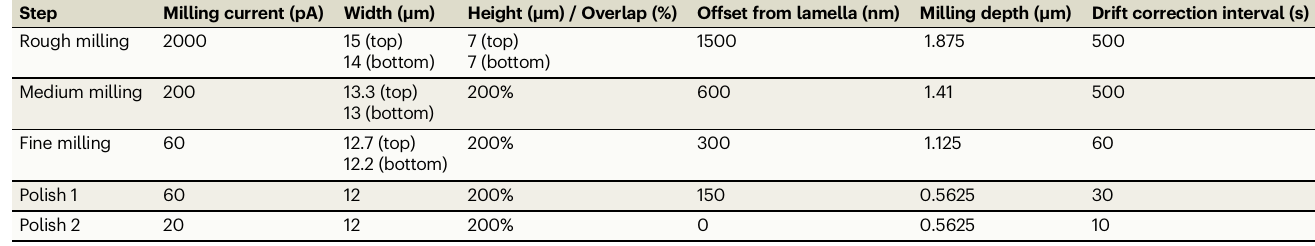
Table 3 | Milling parameters used for lamella preparation Step